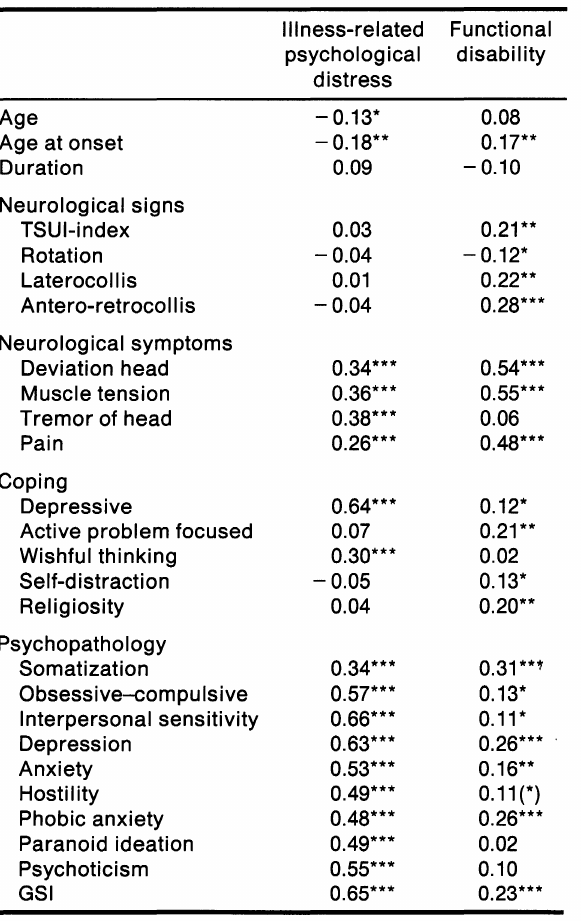
TABLE II. Correlations between psychosocial changes (factor 1 illness-related psychological distress and factor 2 functional disability), signs (neurological assessment), symptoms (self-reported), coping (FKV) and psychopath ology (SCL 90